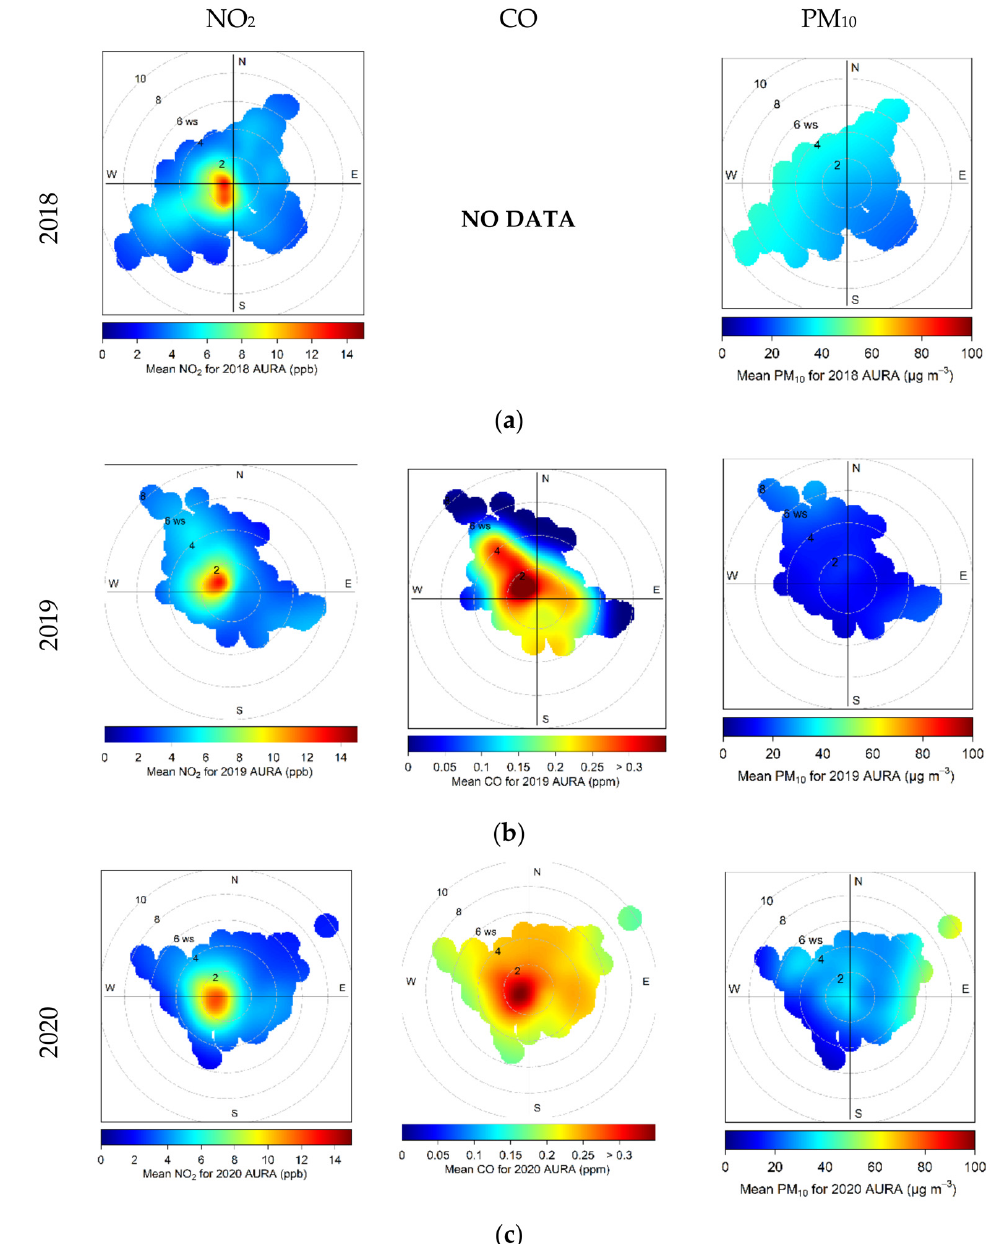
Figure A4. Respective bivariate polar plots for the three main pollutants NO 2 (left column), CO (center column) and PM 10 (right column) of the AURA station for ( a ) 2018, ( b ) 2019 and ( c ) 2020, for the periods before the